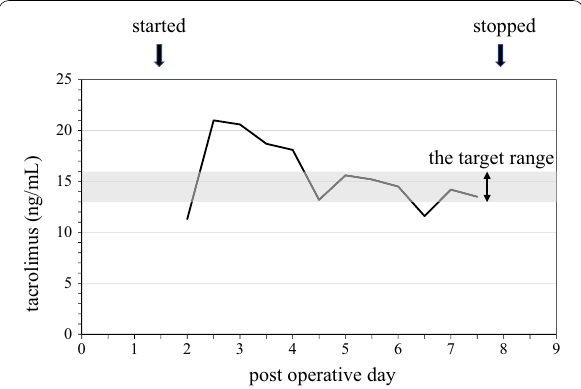
Fig. 1 Trends of blood concentration of tacrolimus after lung transplantation. The blood concentration of tacrolimus